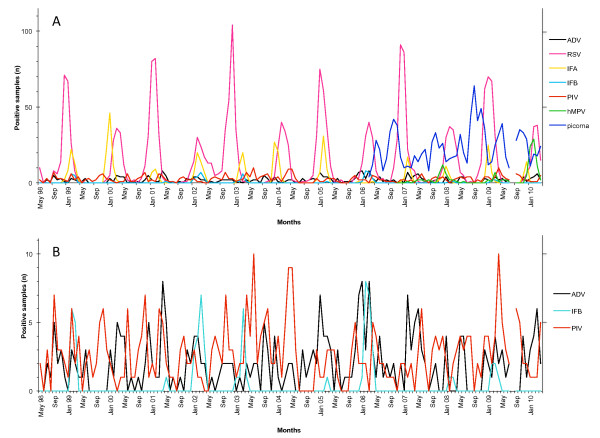
Monthly distribution of respiratory viruses detected by DFA in nasopharyngeal aspirates from hospitalized children between May 1998 and April 2010, with introduction of the hMPV and respiratory picornavirus assays in 2006. A: All viruses detected. B: Detailed view of ADV, IFB and PIV (note that the scale is different than in A). ADV = adenovirus; RSV = respiratory syncytial virus; IFA = influenza A; IFB = influenza B; PIV = parainfluenza viruses 1-3; hMPV = human metapneumovirus; picorna = respiratory picornaviruses.